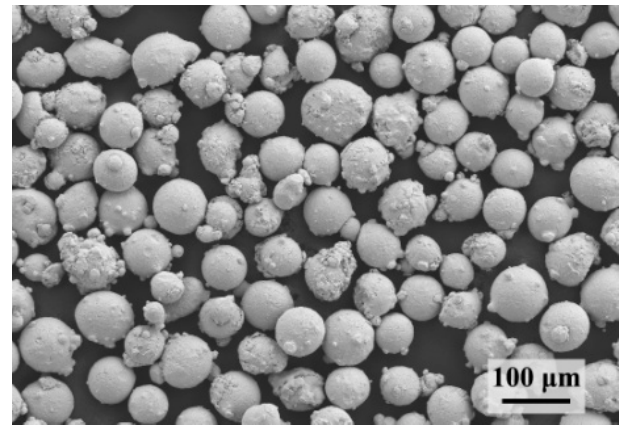
Figure 2. SEM image showing the morphology of H13 powder. Table 1. Chemical composition of steel H13 (wt%), according to the delivery certificate.